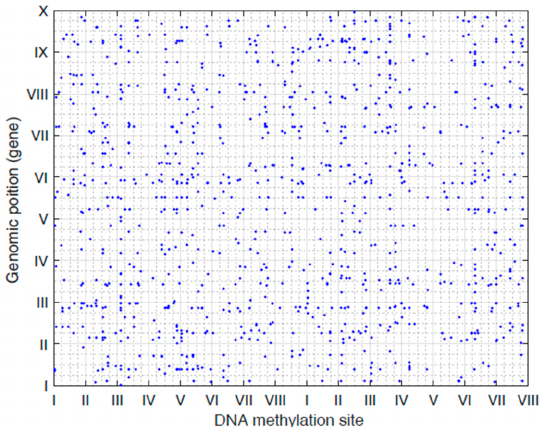
Figure 2. The plot of linkage peaks given by our model (Top 1000 associations based on abs(matrixB) are shown here).